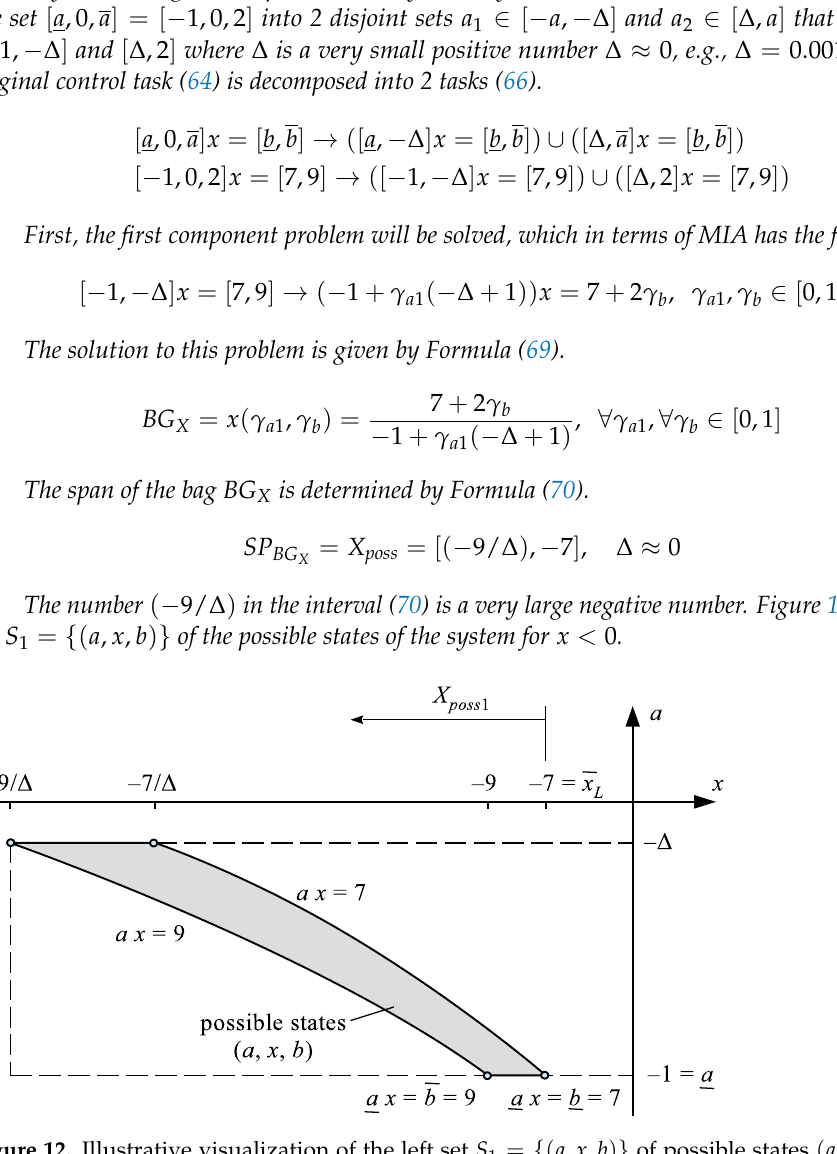
Figure 12. Illustrative visualization of the left set S 1 = { ( a , x , b ) } of possible states ( a , x , b ) of the system [ − 1, − ∆ ] x = [ 7,9 ] , ∆ ≈